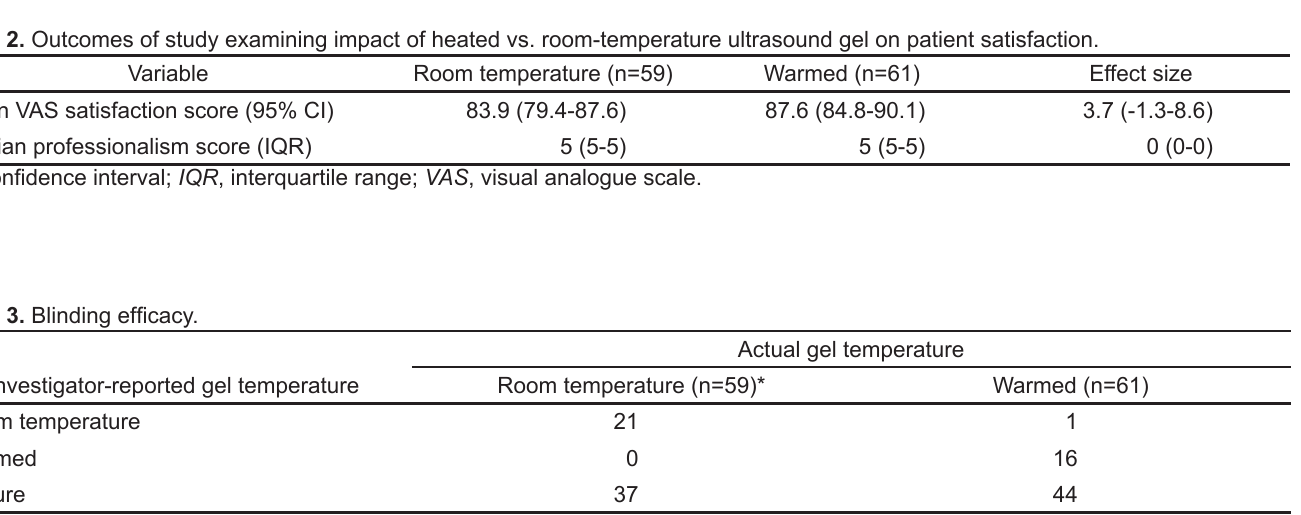
*Data missing for one